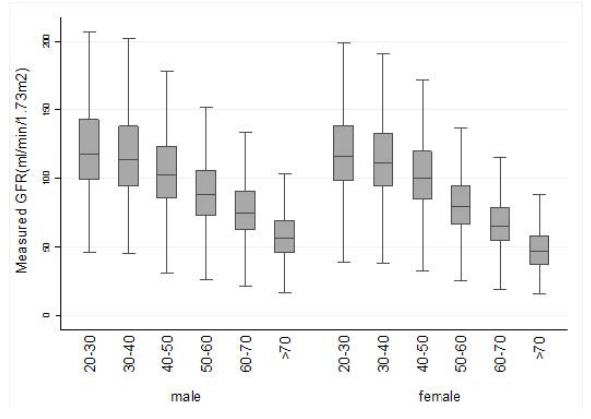
Figure 1. Box plot graph of GFR values in different age groups in terms of